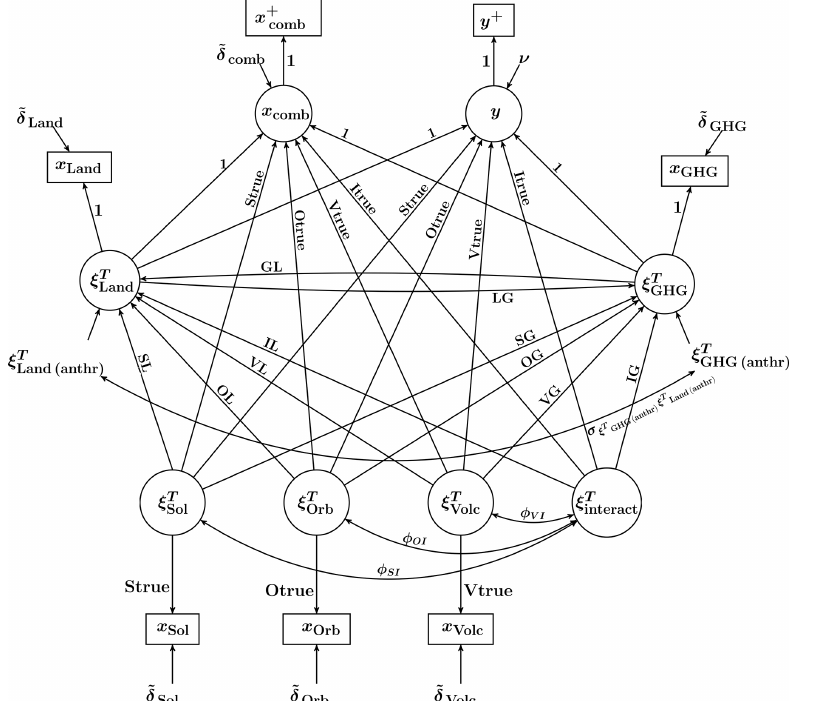
Figure 2. Path diagram of a non-recursive (i.e. containing reciprocal relationships) SEM model under the hypothesis of consistency. The variance of each specific factor ˜ δ f is assumed to be known a